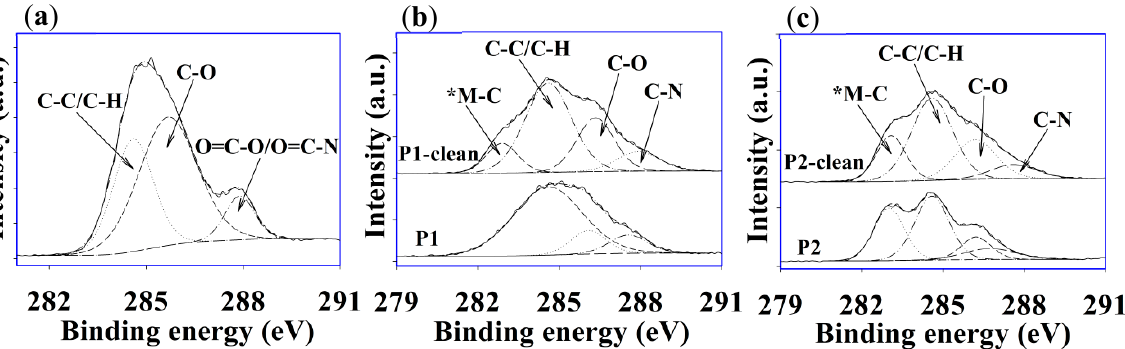
Figure 10. XPS high-resolution C 1s peak of ( a ) virgin, ( b ) P1 and P1-clean, and ( c ) P2 and P2-clean membranes.